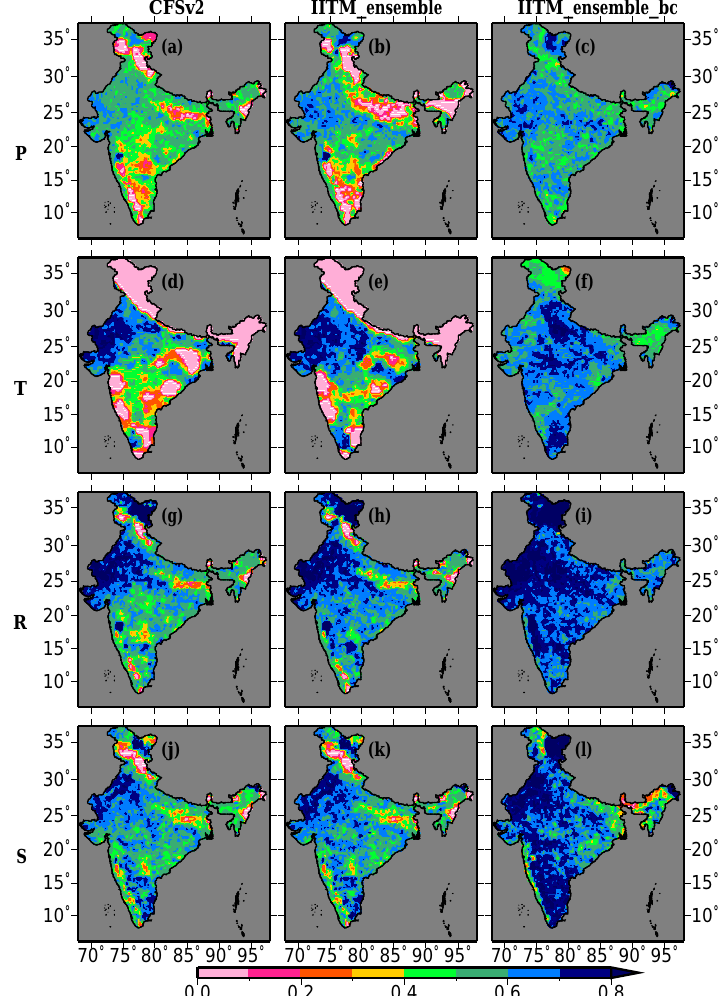
Figure 4. Critical success index (CSI, averaged for forecast dates) of predicting precipitation (a–c) , temperature (d–f) , runoff (g–i) , and soil moisture (j–l) anomalies with respect to the observed anomalies for CSFv2, the IITM ensemble, and the bias corrected IITM ensemble (IITM